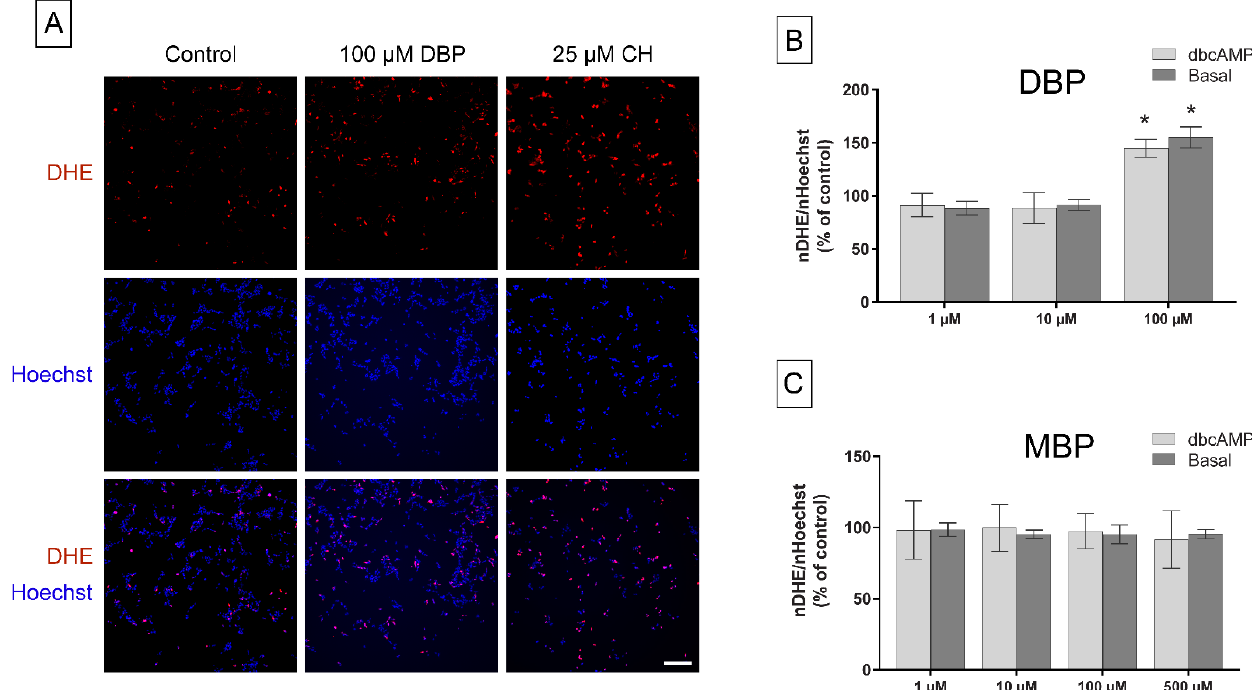
Figure 8. Superoxide levels were measured in H295R cells after 2 h exposure to DBP or MBP. Representative images of cells stained with Hoechst (blue) or DHE (red) and composite images are shown of cells exposed to solvent control (0.1% DMSO), 100 µM DBP, or 25 µM cumene hydroperoxide (CH, positive control; ( A ). Changes in superoxide levels after 2 h exposure to DBP ( B ) or MBP ( C ), with or without stimulation of the steroidogenesis by 0.1 mM dbcAMP, were calculated as the number of DHE-stained objects per image divided by the number of Hoechst-stained objects. Values represent mean ± S.D. calculated as % of control for three replicates, where the average of six wells/treatment was calculated for each replicate. Statistically significant differences from a theoretical mean of 100 are indicated as follows: * p < 0.05 (One Sample t -test). Scale bar = 200 µ